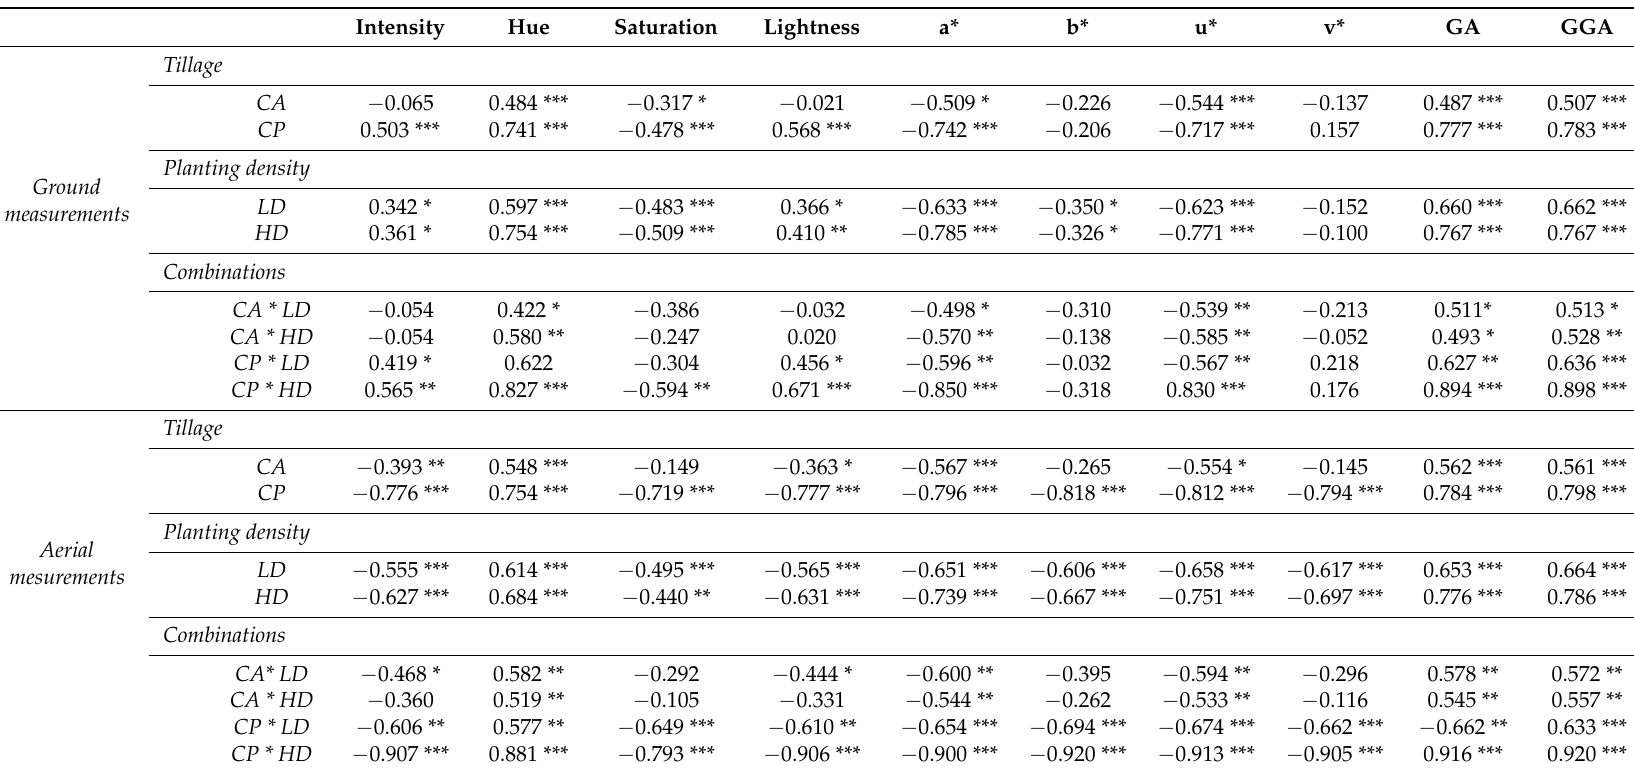
Table 6. Regression coefficients of the relationships between the RGB-indices, measured at ground and aerial levels, with grain yield. These indices are defined at section Material and Methods. Level of significance ( p -value): *, p < 0.05; **, p < 0.01; ***, p < 0.001. Treatments: CA, conservation agriculture; CP, conventional agriculture; LD, low density; HD, high